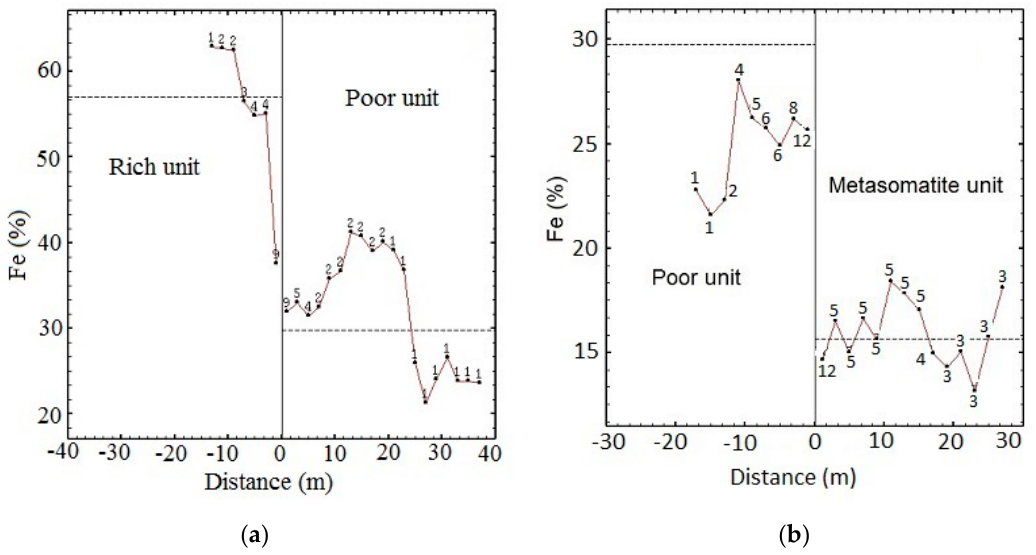
Figure 10. Contact plot showing the mean Fe (%) in a rich domain (left), and poor domain (right) ( a ); contact plot showing the mean Fe (%) in a poor domain (left), and metasomatite domain (right) ( b ).